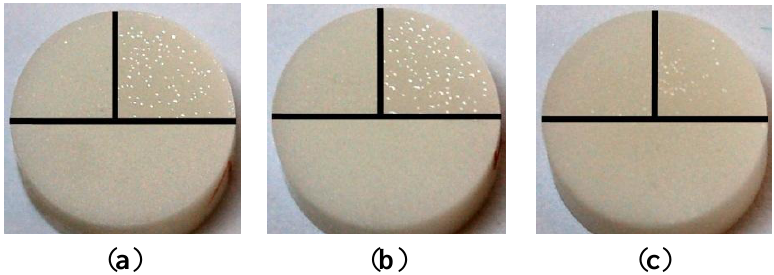
Figure 3. TZP-A specimens partly coated with glass solder: ( a ) HT1; ( b ) LT1; and ( c ) LT2 with each bottom half being uncoated, the right upper quarter being coated with raw glass solder and the left upper quarter being coated and